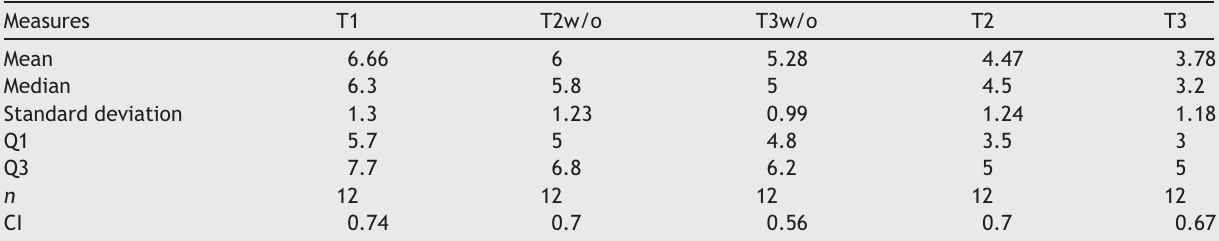
Descriptive statistics and comparative study among time points of evaluation for the feeling of sound intensity (dB SL) of tinnitus in the right ear (TG).